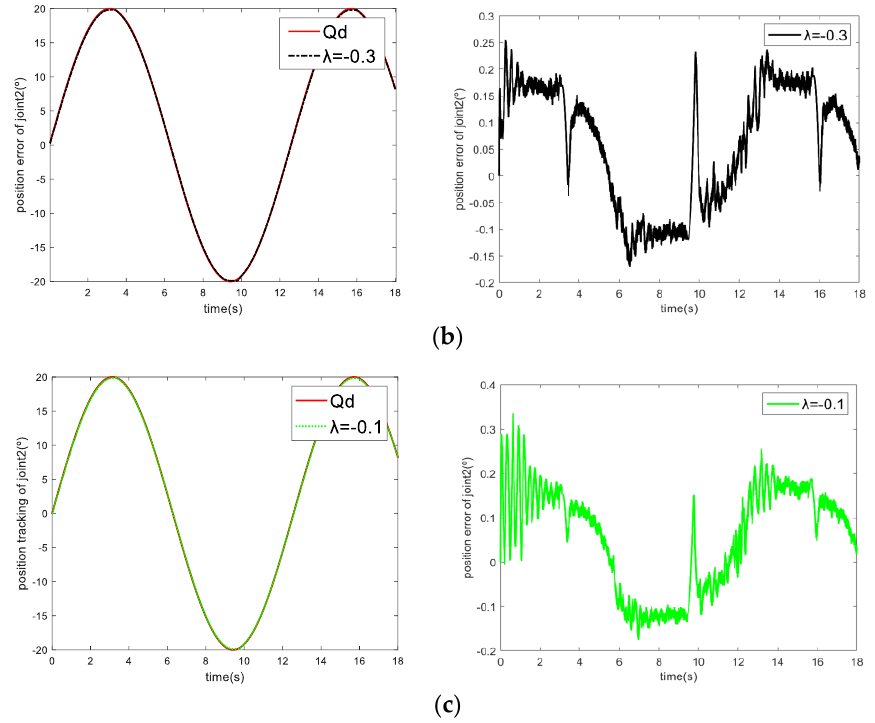
Figure 5. Tacking effect of joint 2 with different A. ( a ) λ = − 0.45; ( b ) λ = − 0.3; ( c ) λ = − 0.1. Case 4: Simultaneous tracking of sinusoidal trajectories by dual